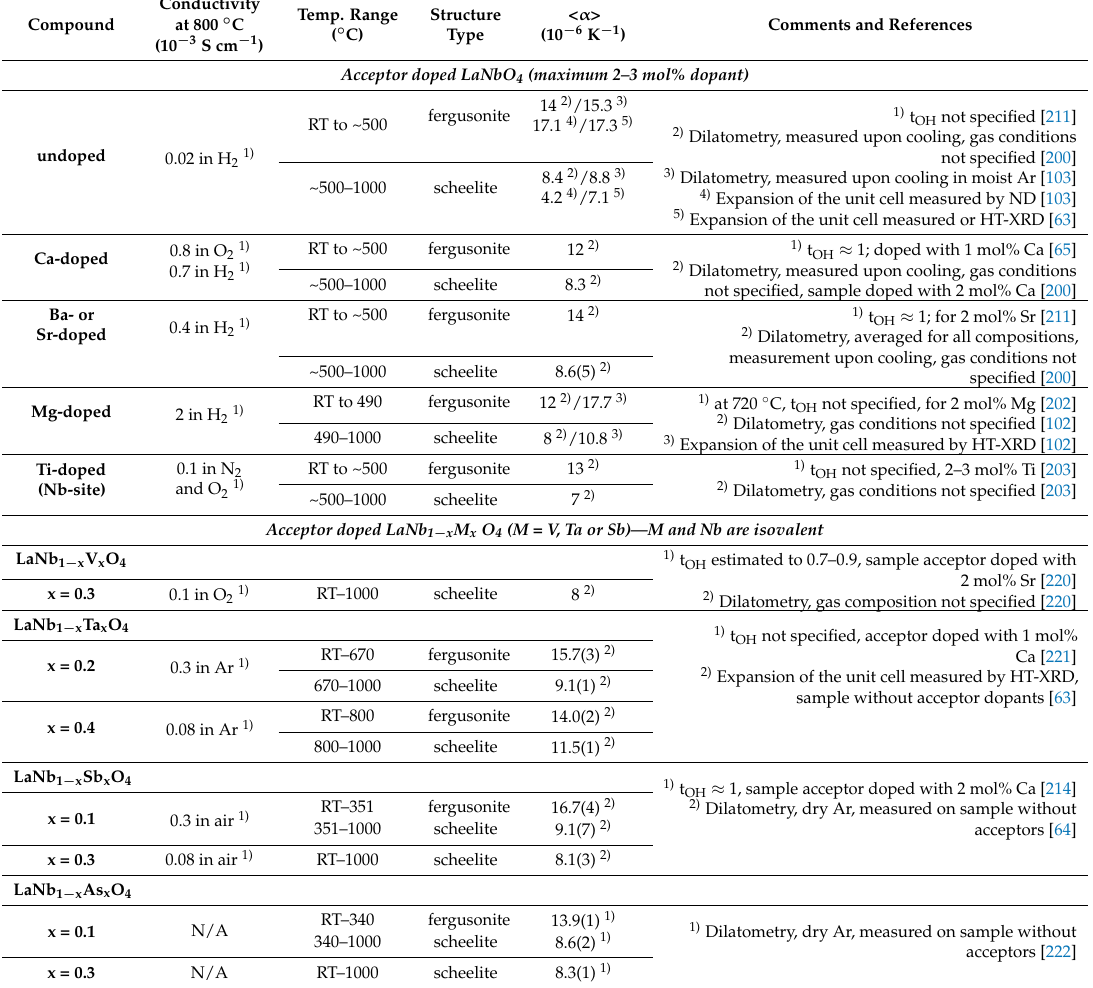
Table 4. Thermal expansion coefficients of undoped and cation-substituted LaNbO 4 compounds, along with their total conductivity at 800 ◦ C under wet conditions and their structure type for reference. Note that acceptor dopants are generally on the La-site unless specified